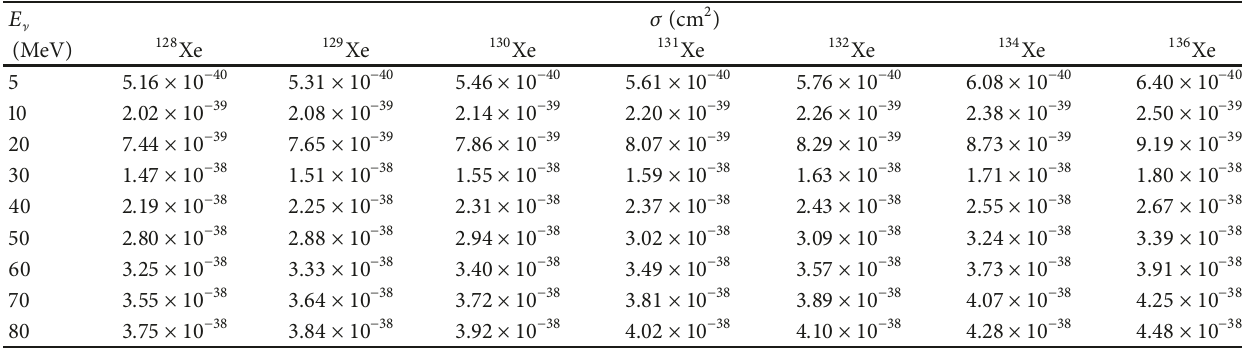
Table 3: Coherent elastic neutral-current scattering cross section for neutrinos scattering off xenon targets as a function of neutrino energy. The cross sections for eachisotope are given in units of cm 2 in columns 2-8 as a function of the neutrino energy (column 1). The computations were made in the nuclear shell model.